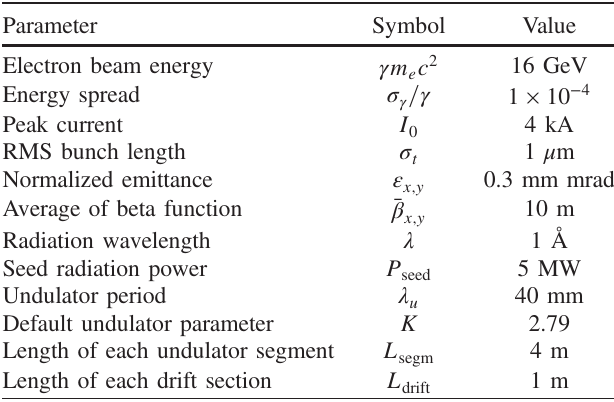
TABLE II. Parameters of the time-dependent